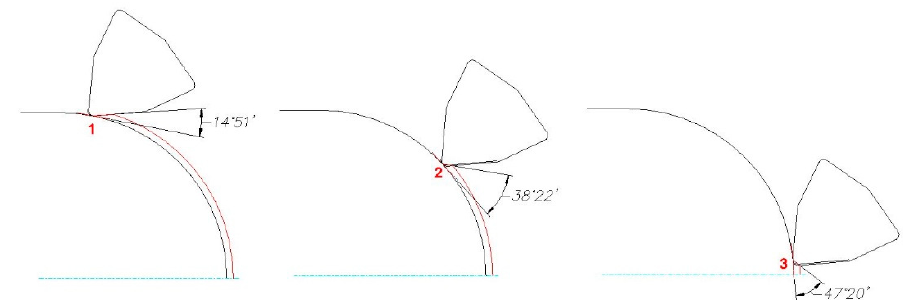
Figure 2. Change of the angle between the main cutting edge and the machined surface during: ( a ) longitudinal turning; ( b ) taper turning 30°; ( c ) taper turning 45°. The surface roughness on the sphere was measured in three locations (Figure 3).